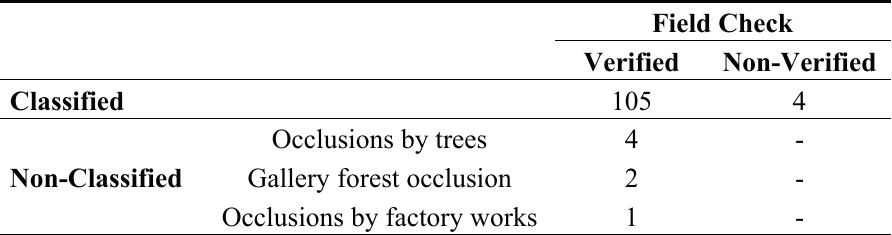
Table 2. Summary of field verification for LWD classification.